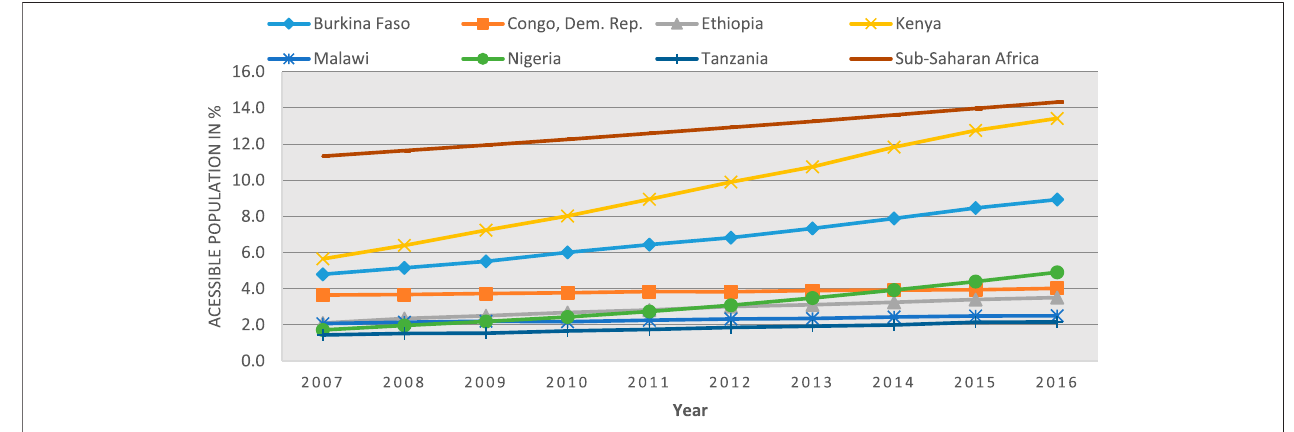
FIGURE 1 | Proportion of population access to clean fuels and technologies for cooking (% of the population) (World Bank, 2017).